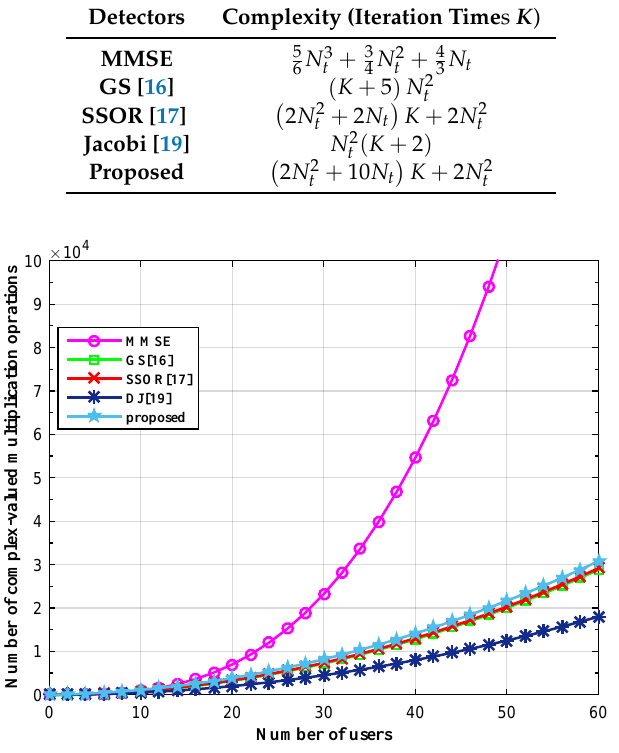
Figure 3. Complexity comparison against the number of users with K =